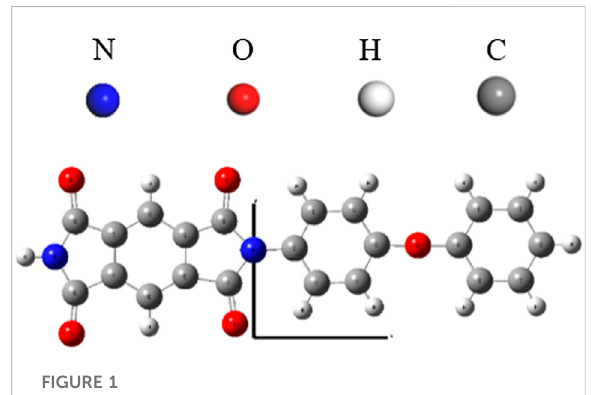
FIGURE 1 Polyimide molecular model.